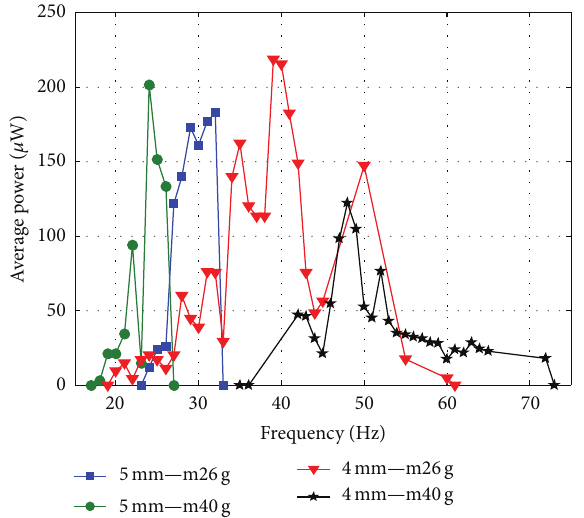
Figure 13: Plot of average output power (5ms) versus